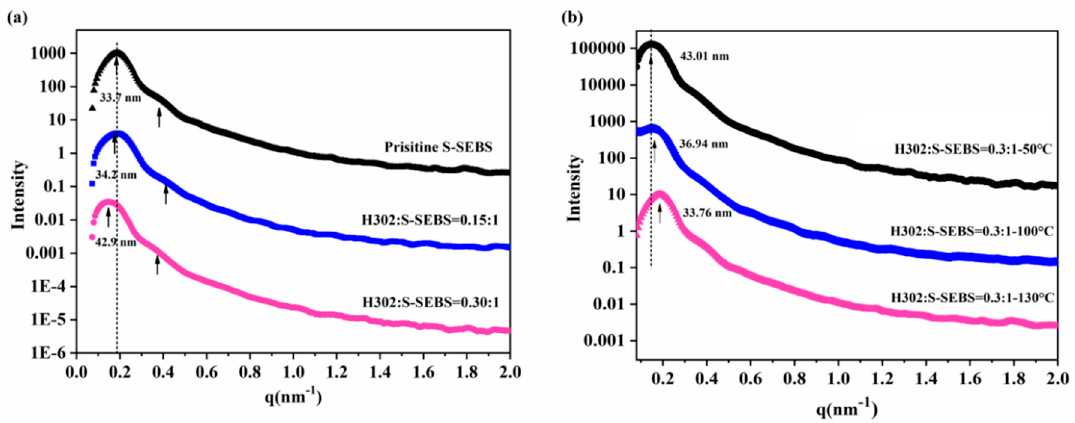
Figure 5. SAXS profiles of H302/S-SEBS membranes ( a ) without thermal treatment ( b ) with thermal